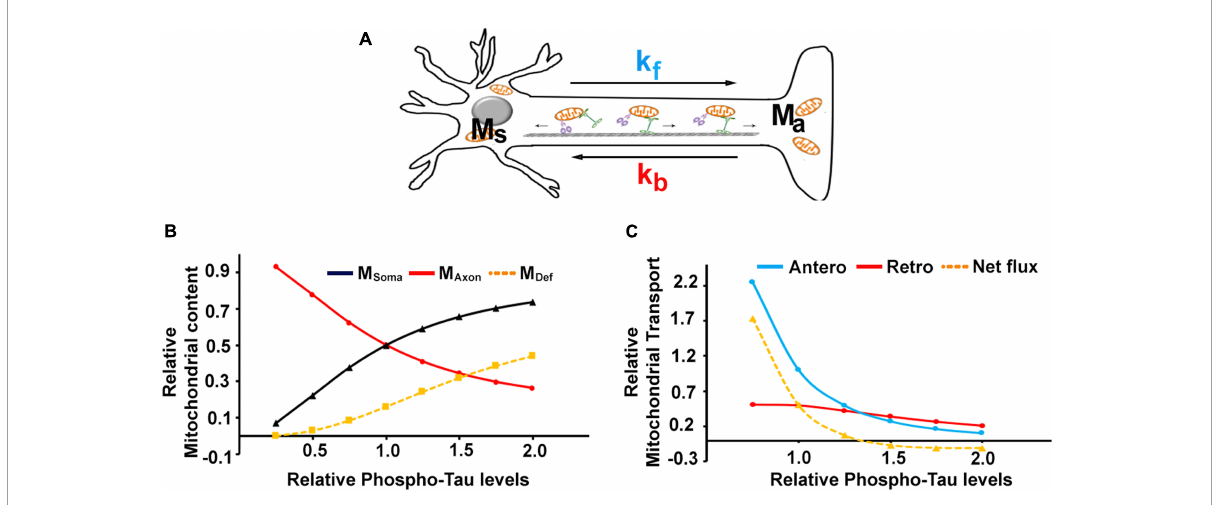
FIGURE5 Mathematical modeling of mitochondrial transport in P301L neurons: (A) Schematic representation of parameters used to model the mitochondrial transport in neurons. M soma and M axon denote mitochondrial mass in the soma and axon compartments and M Def denotes defective mitochondria. k f and k b represent kinesin and dynein mediated flux, respectively. Experimental datasets can be fitted into simple equations to simulate the effect of phospho-tau on (B) mitochondrial content and (C) transport parameters. The model was simulated for varying levels of Tau phosphorylation between 0.5 and 2-fold, where the level of tau phosphorylation in controls was considered 1 and 1.5 for the disease phenotype, as P301L displayed exhibited a 50% rise in